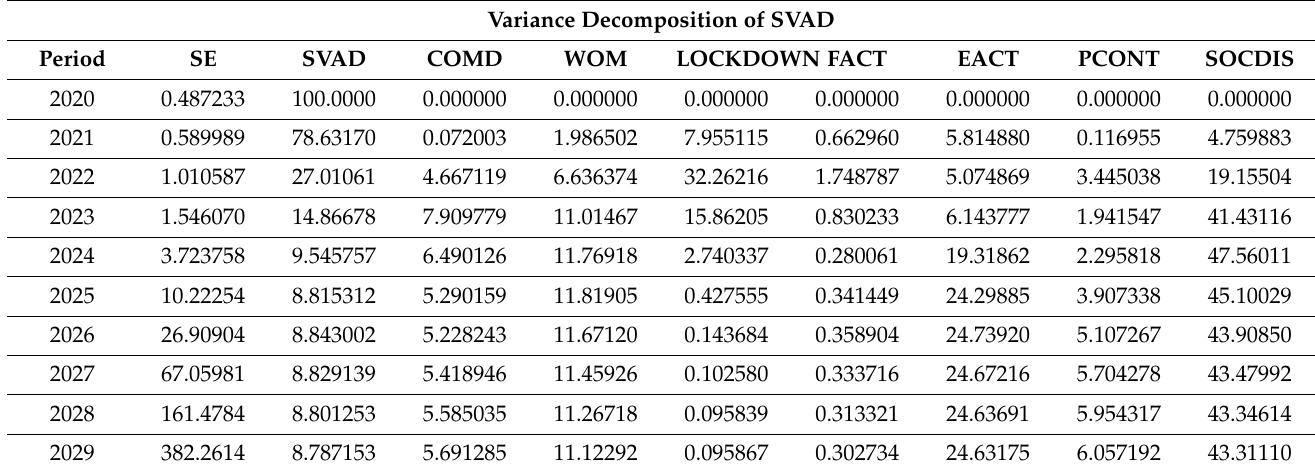
Table 8. Variance Decomposition Analysis (VDA) Estimates. Variance Decomposition of